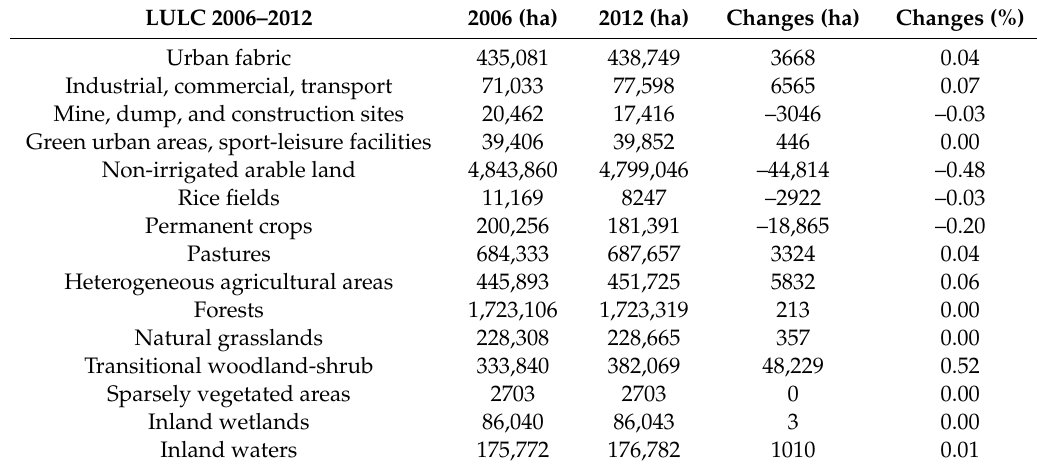
Table A3. Area a ff ected by LULC change in Hungary between 2006 and 2012.